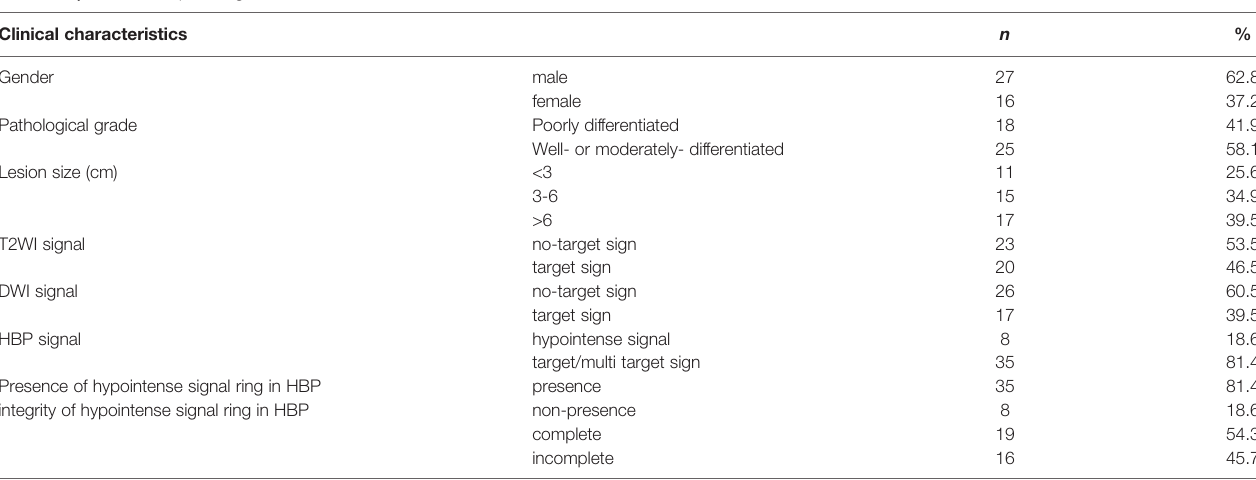
TABLE 1 | Clinical and pathological information. Clinical